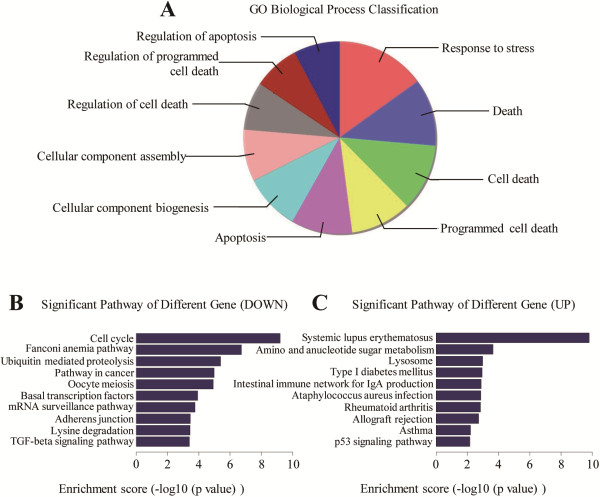
Changes of the gene expression profiling. After fenofibrate treatment, (A) the top ten most obvious changes in GO biological process classification confirmed that fenofibrate could induce apoptosis of MDA-MB-231 cells. (B) Cell cycle pathway ranked first in the top ten most significant down-regulated pathways. (C) p53 pathway ranked tenth in the top ten most significant up-regulated pathways.